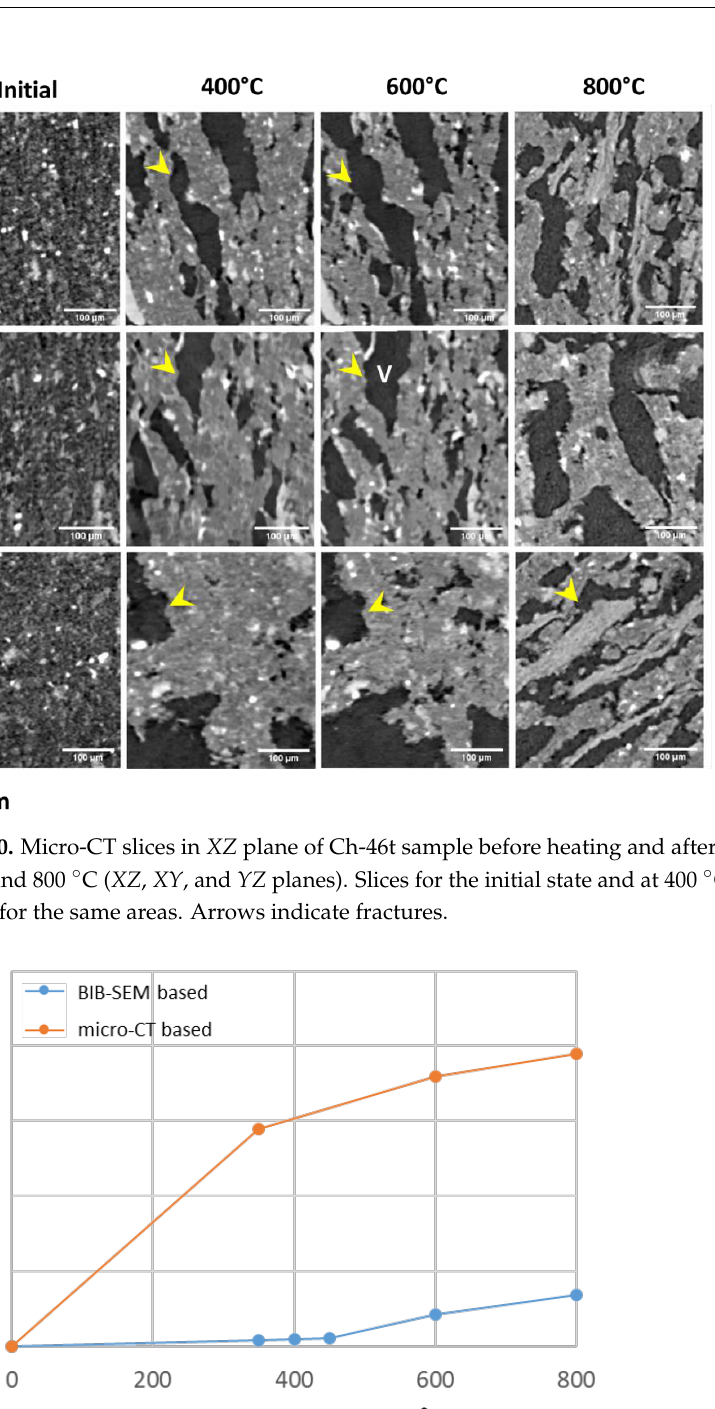
Figure 11. Porosity change during treatment based on BIB-SEM scanning and micro-CT. The significant difference in porosity was caused by the accounting of all resolved fractures by micro-CT, whereas SEM only accounted for pores in the carbonate matrix and kerogen.